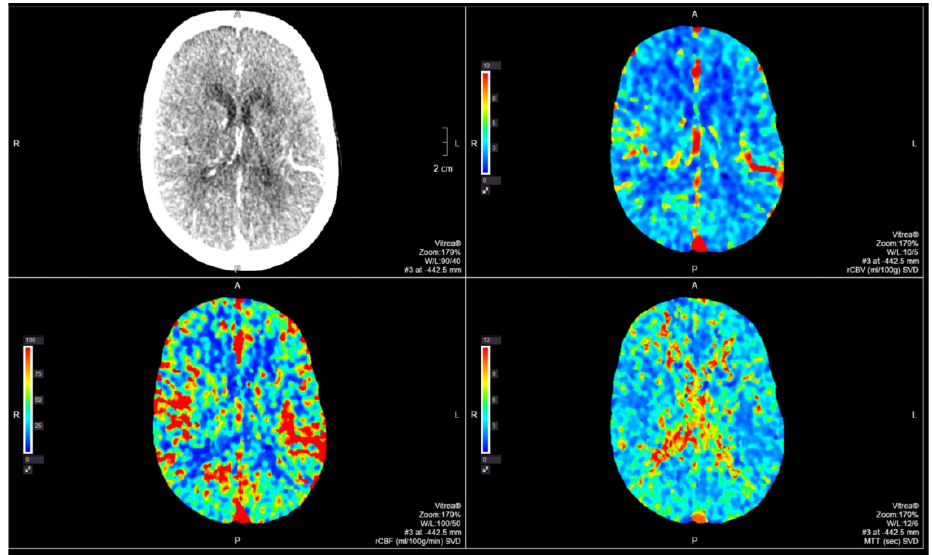
Figure 2. No alterations are observed in the parametric maps (mean transit time, flow or brain volume) suggesting acute cerebral ischemia.